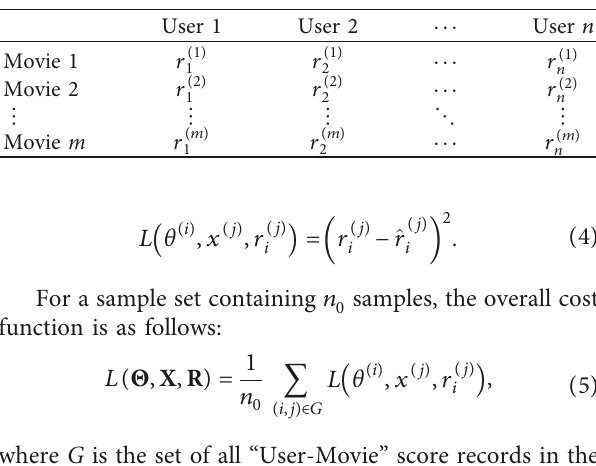
Table 1: “User-Movie” score